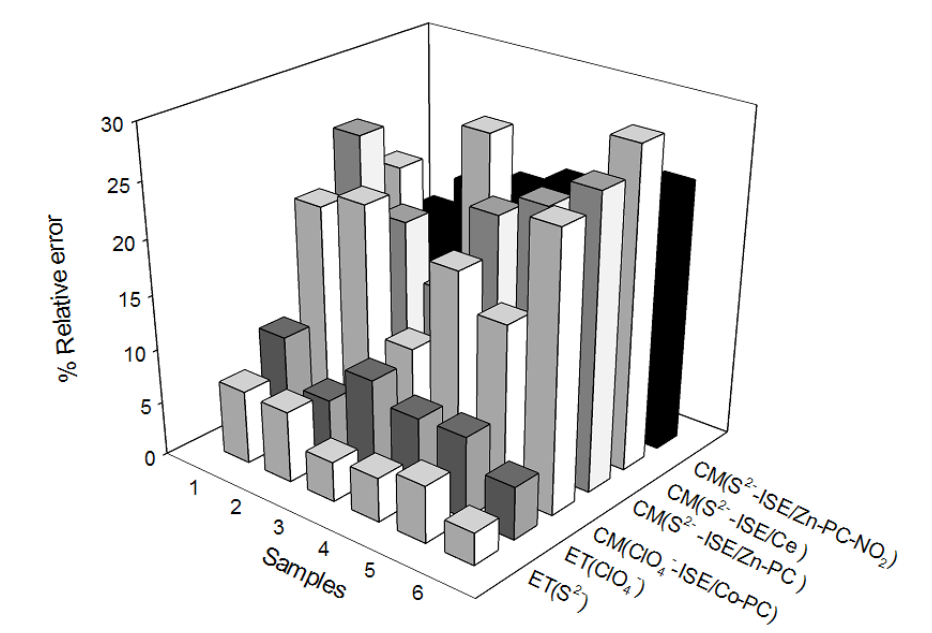
Figure 5. Absolute errors (%) obtained for the simultaneous determination of sulfide and perchlorate in synthetic samples by the proposed electronic tongue and by use of standard potentiometry with each individual ISE in the